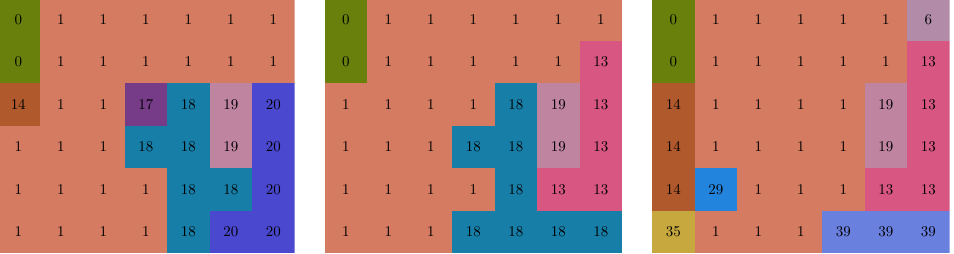
Figure 7. Results for A 1 ( left ), A 2 ( center ) and A 3 ( right ), for organic matter instance with α = 0.4.